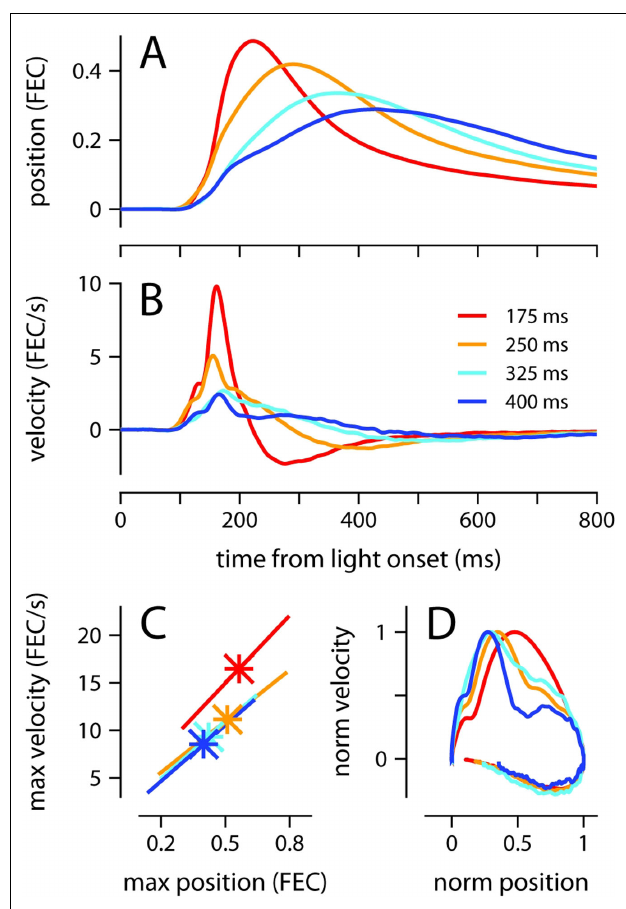
FIGURE 1 | Kinematic properties of the conditioned eyelid movement. (A) Average eyelid position, and (B) average eyelid velocity for mice trained with four different ISIs. (C) Asterisks indicate the average maximum position and maximum velocity for each ISI. X-range of the linear regression lines is mean of position maxima ± std across all trials for a particular ISI. (D) Normalized phase plots for the data shown in (A,B) . Color code for all plots indicates trained ISI and is shown in (B) . FEC, fraction eyelid